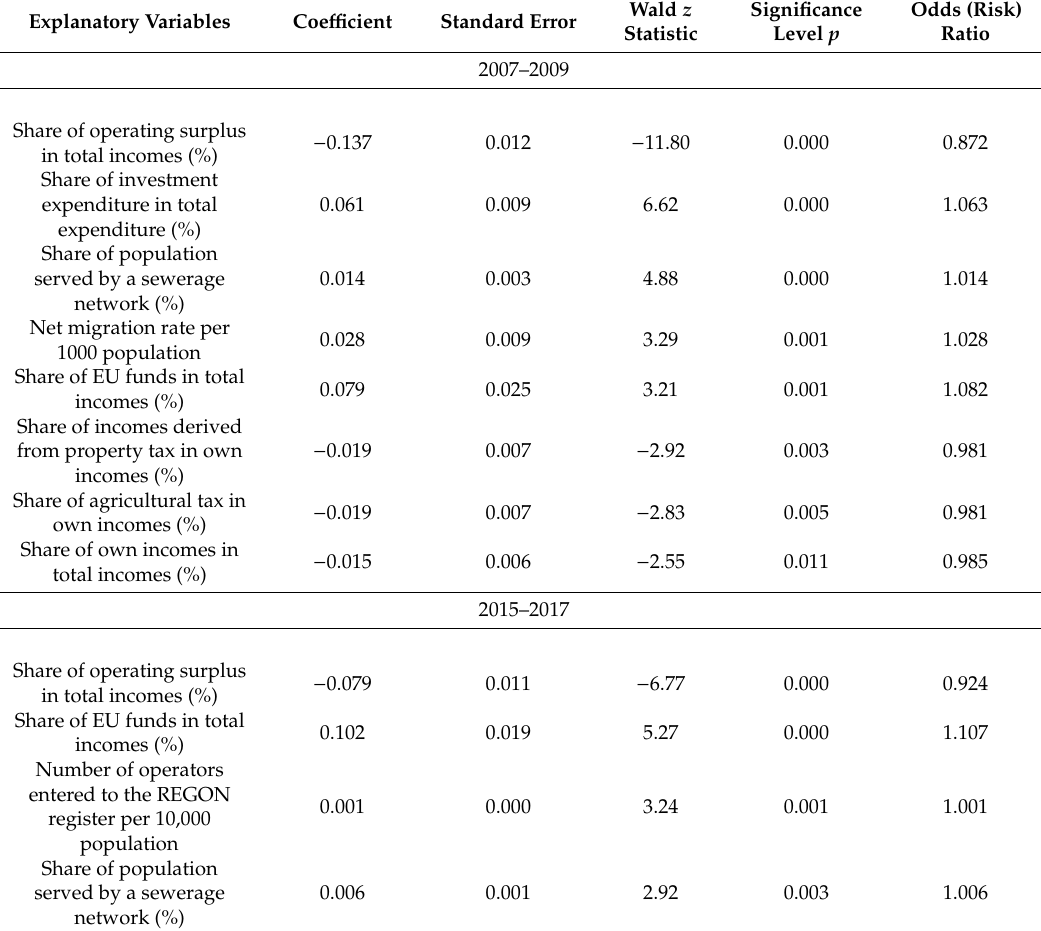
Table 7. Estimation results for the parameters of the ordered logit models for debt levels of Polish rural municipalities in 2007–2009 and